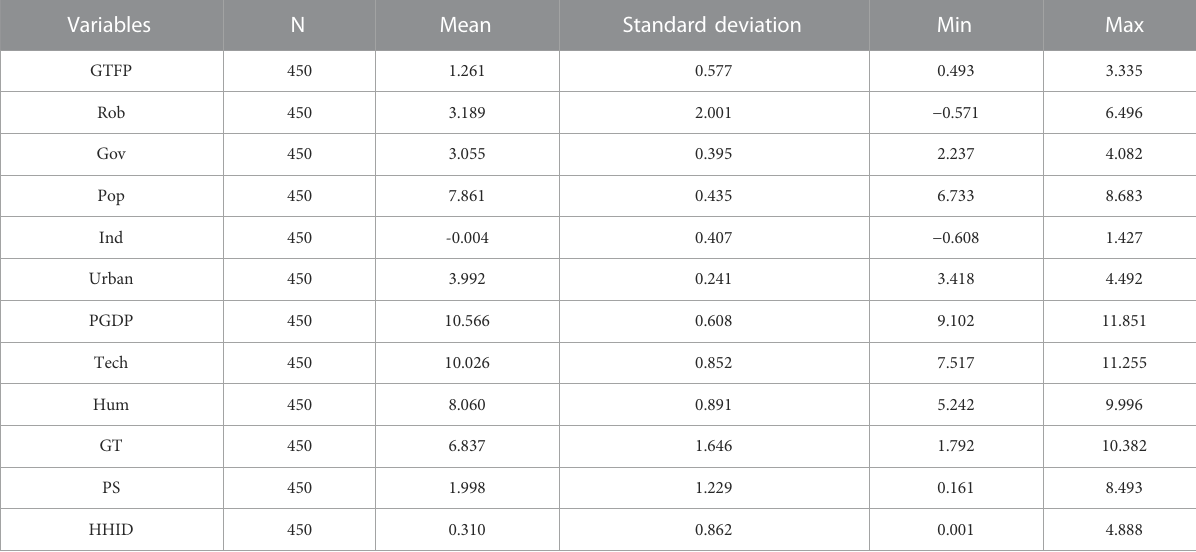
TABLE 1 Descriptive statistical for variables.